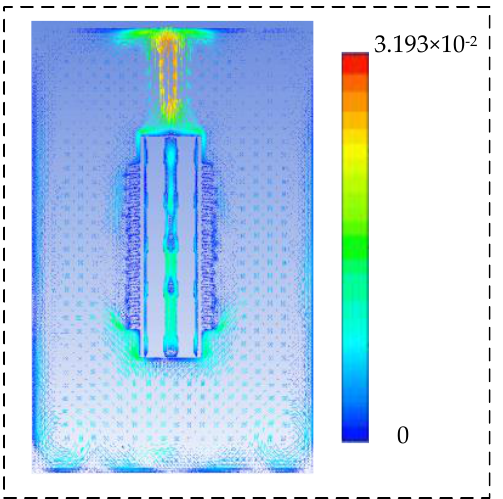
Figure 8. The flow line diagram of the SF 6 fluid in the multi-column arrester under monopole earth loop operation mode.